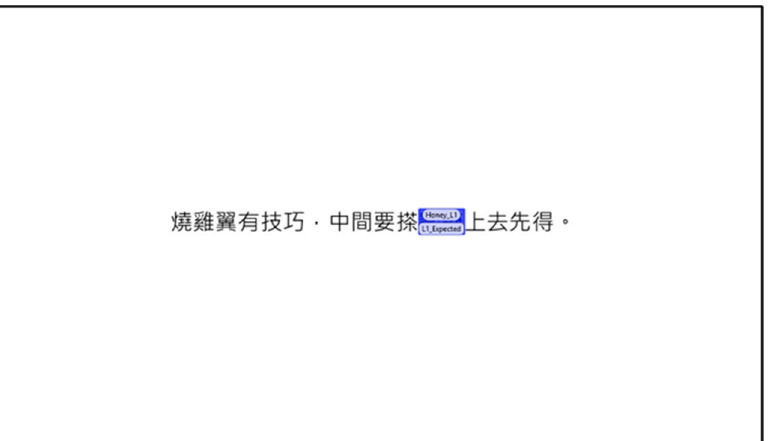
Figure 1. Example of the stimuli and the AOI. In each trial, a one-line sentence would be presented to the participants. The critical word was marked with a blue square in the figure as the Area of Interest (AOI) to be analysed. The blue square was for illustration only and was not visible to the participants. The stimulus is translated to “There’s skill in barbecuing chicken wings, you have to add honey to make it work.”, with “honey” being the AOI marked in